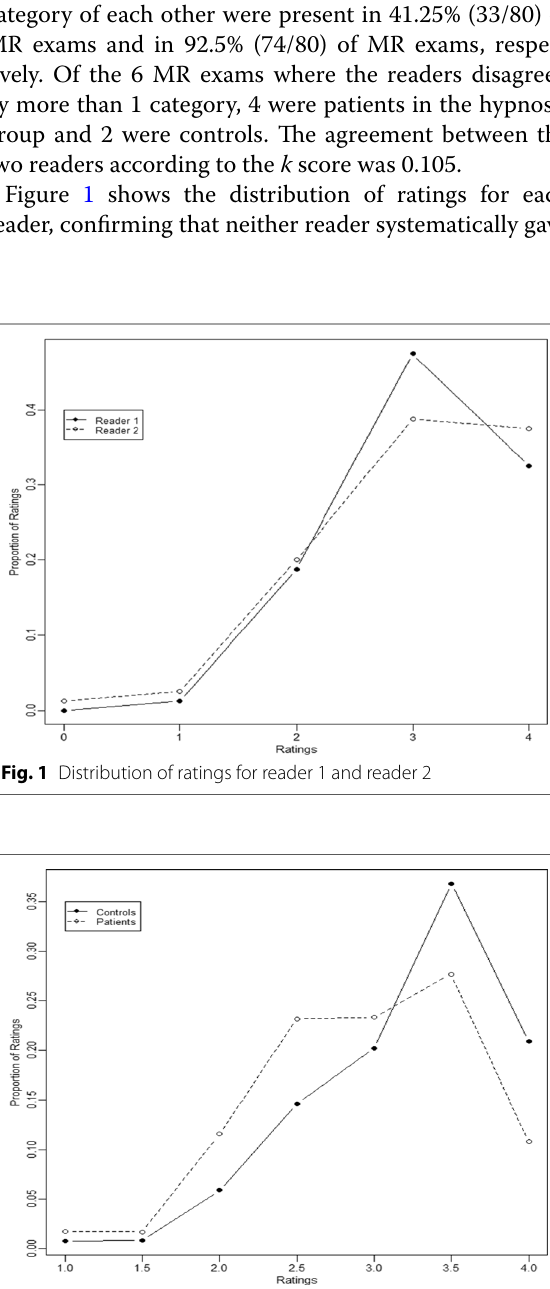
Fig. 2 Distributions of average reader